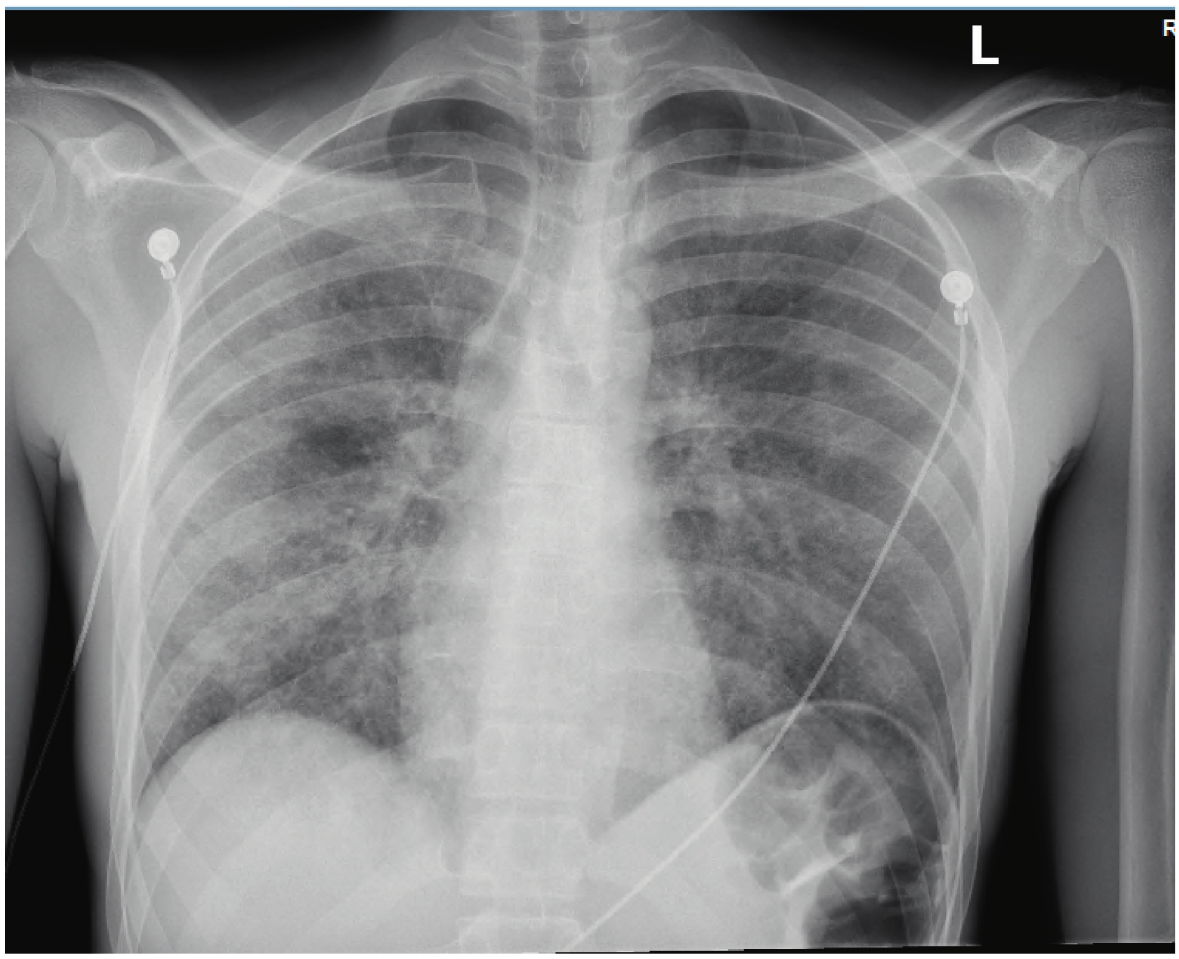
Figure 1: CXR showing bilateral pulmonary